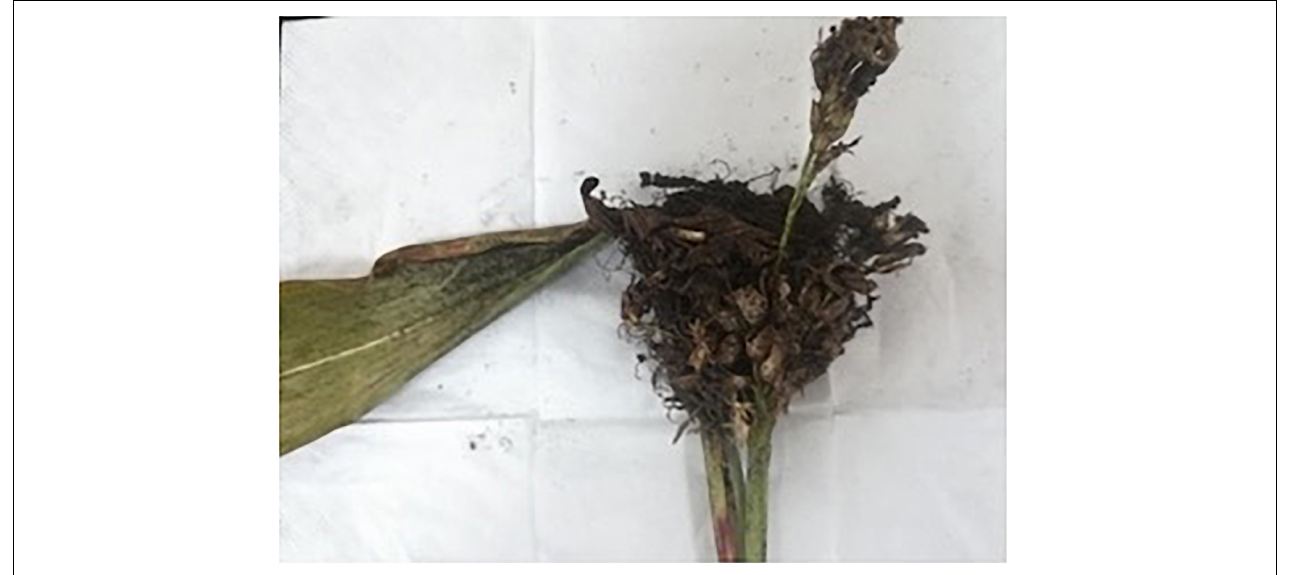
FIGURE 1 | Characteristic symptoms of sorghum head smut caused by S. reilianum in naturally infected, smutted panicles of sorghum plants growing in Qianxi county, Guizhou Province, China.